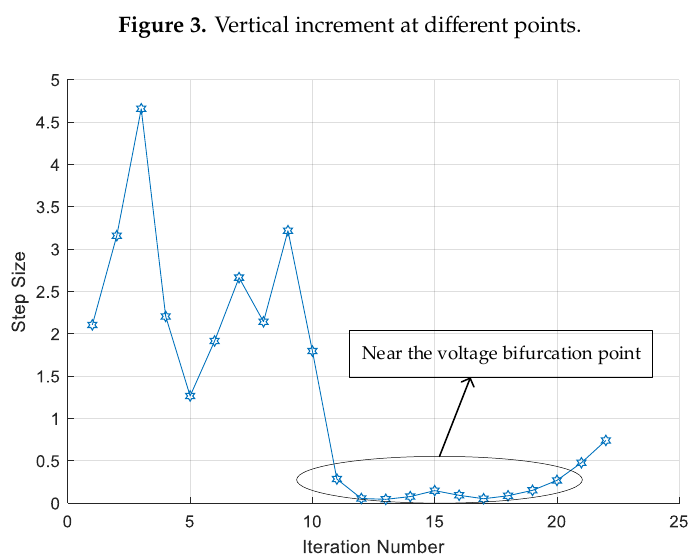
Figure 3. Vertical increment at different points.